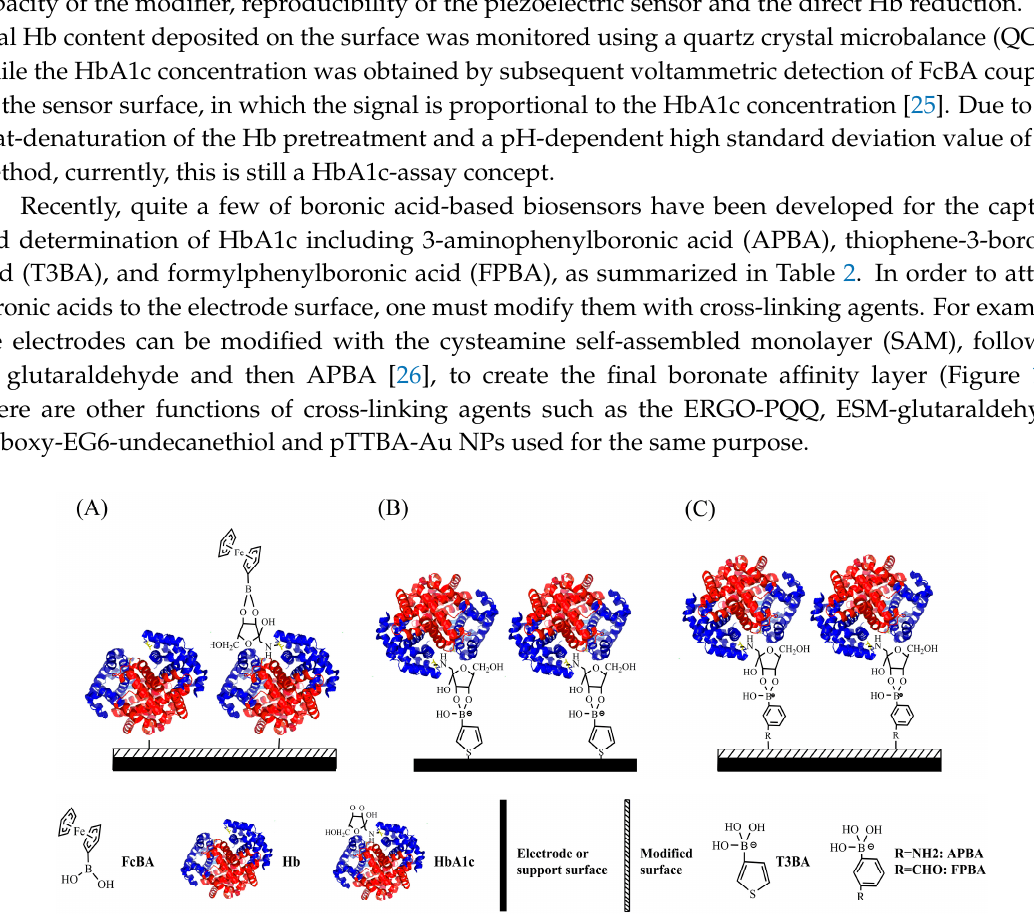
Figure 1. Schematic illustration of construction of boronic acid-based HbA1c sensors by using ( A ) FcBA; ( B ) T3BA; and ( C ) APBA or FPBA for HbA1c recognition.